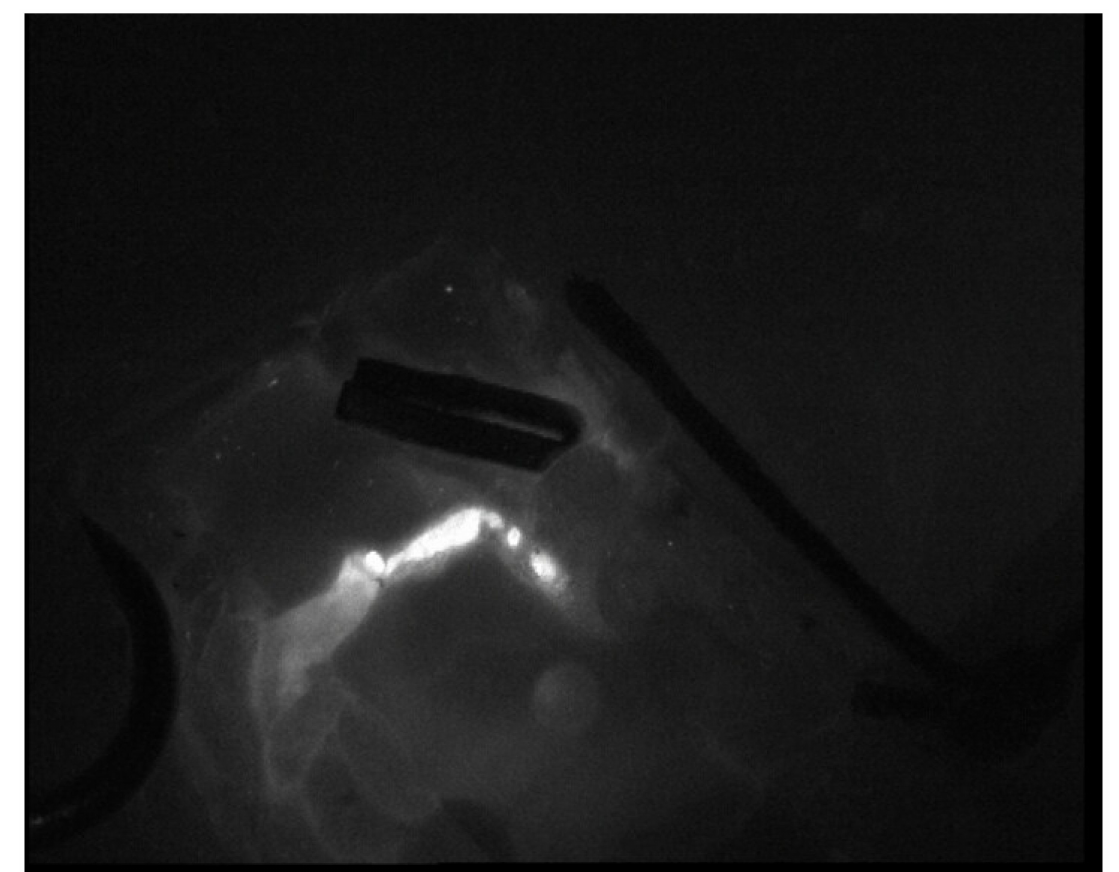
Figure 2. Confirmation of patency of lymphaticovenous anastomosis with ICG lymphangiography in Figure